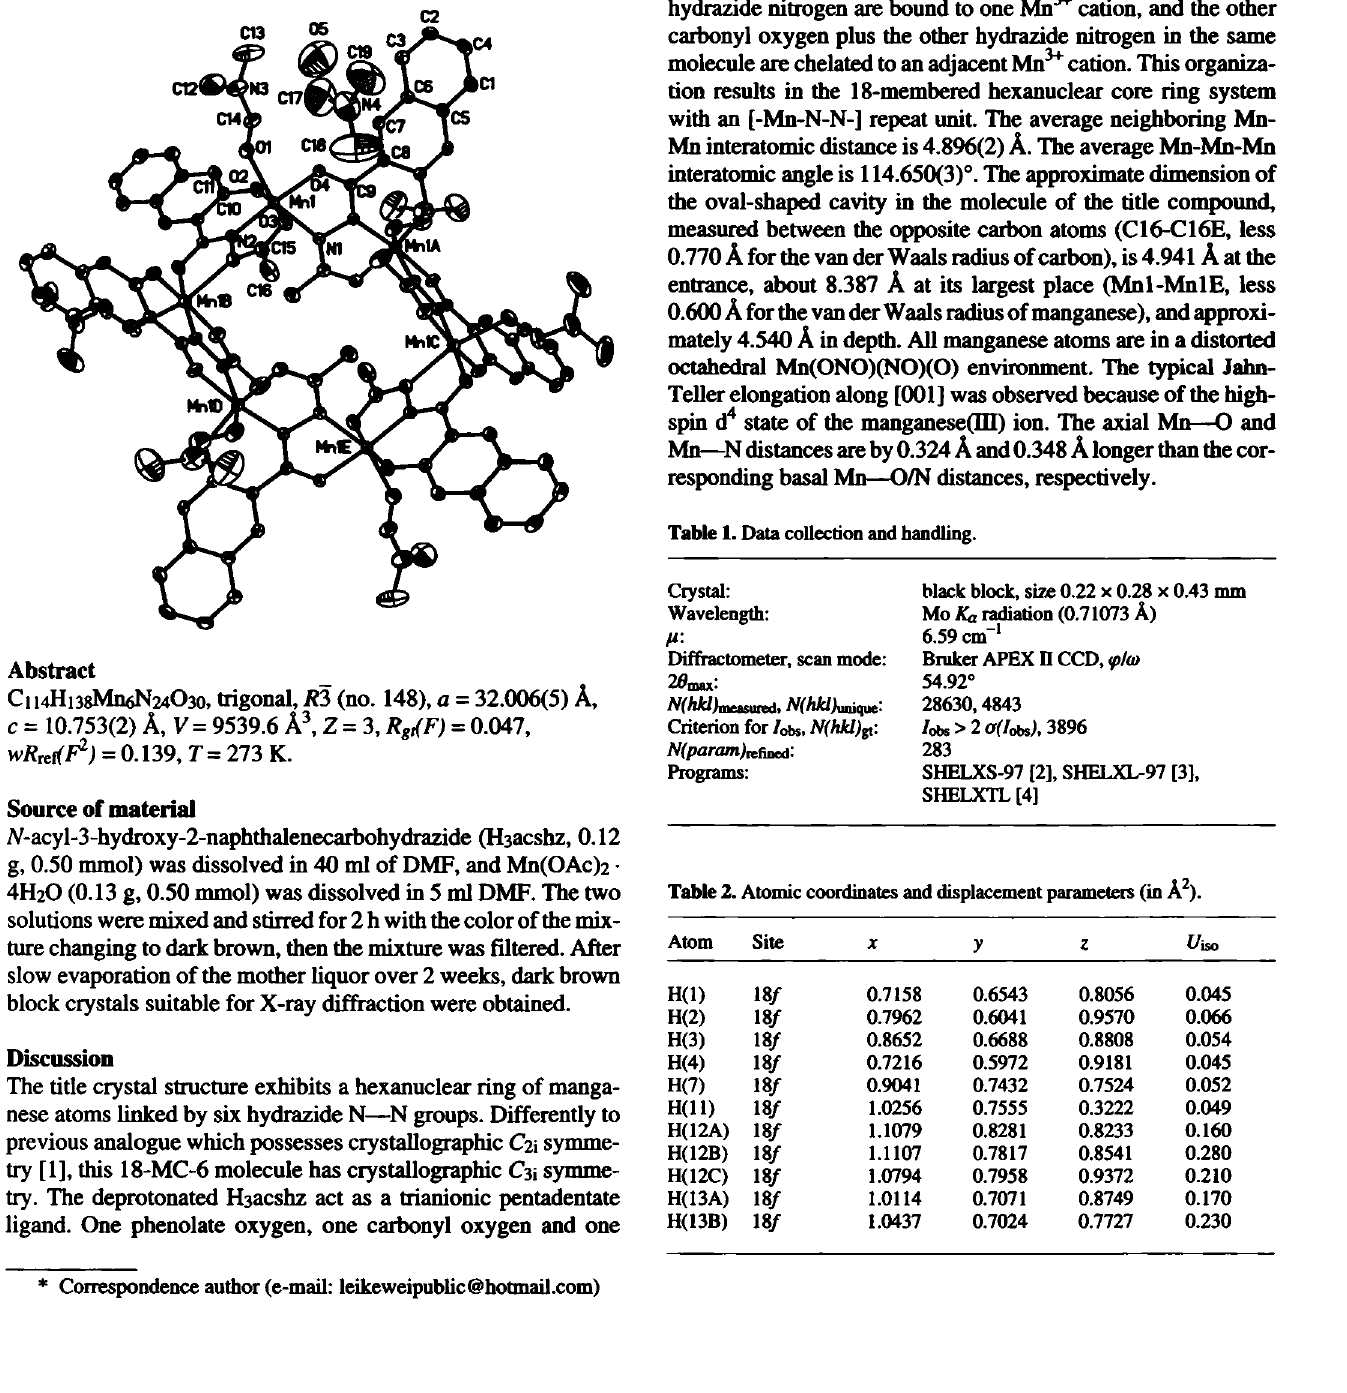
Table 2. Atomic coordinates and displacement parameters (in Â 2